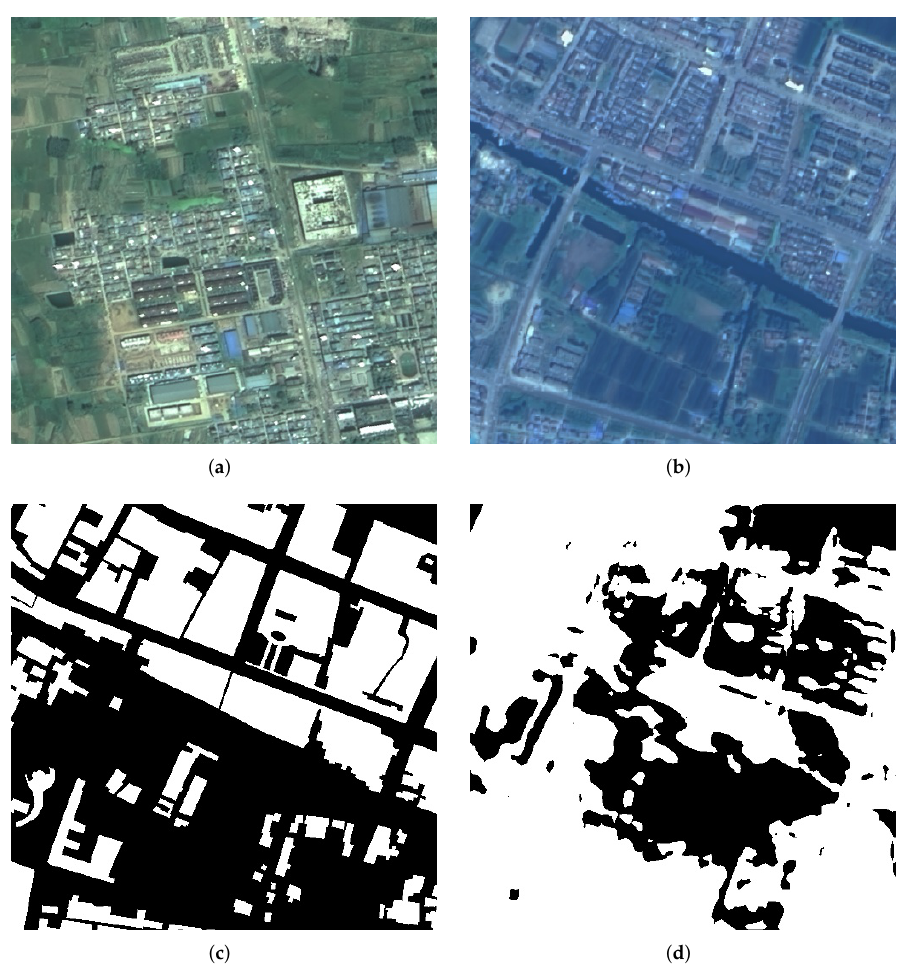
Figure 1. An example of the domain adaptation. We show the source images and the target images which are obtained from different satellites, the label of the target image and the prediction of DeeplabV3+. In the label and the prediction, black and white pixels represent background and buildings respectively. ( a ) Source image. ( b ) Target image. ( c ) Label of the target image. ( d ) Prediction for the target